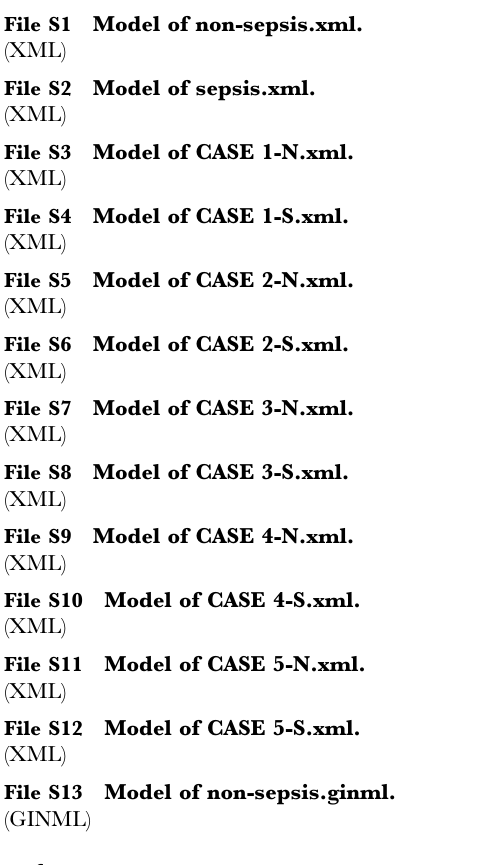
Figure S11 Dummy tendency graphs of NF k B repre- senting the associated logical parameters used in the modelling of non-septic condition. Figure S12 Dummy tendency graphs of PICyts repre- senting the associated logical parameters used in the modelling of non-septic condition. Figure S13 Dummy tendency graphs of SOCS-1 repre- senting the associated logical parameters used in the modelling of non-septic condition. Table S1 Other intervention studies. Other CASES of intervention in signalling were derived by removing specific interactions in Figure 2 along with their logical parameters to observe the possible stable states produced due to each